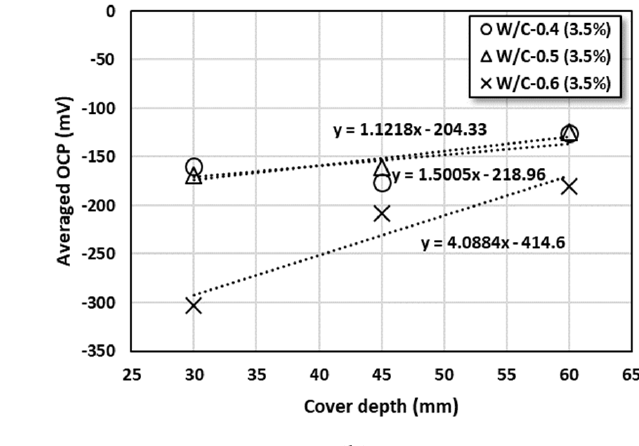
( c ) Figure 10. Photos of the corroded area with increasing chloride concentration after 1 year: ( a ) 0.0%, ( b ) 3.0%, and ( c ) 7.0% (cover depth: 45 mm, w/c : 60%).